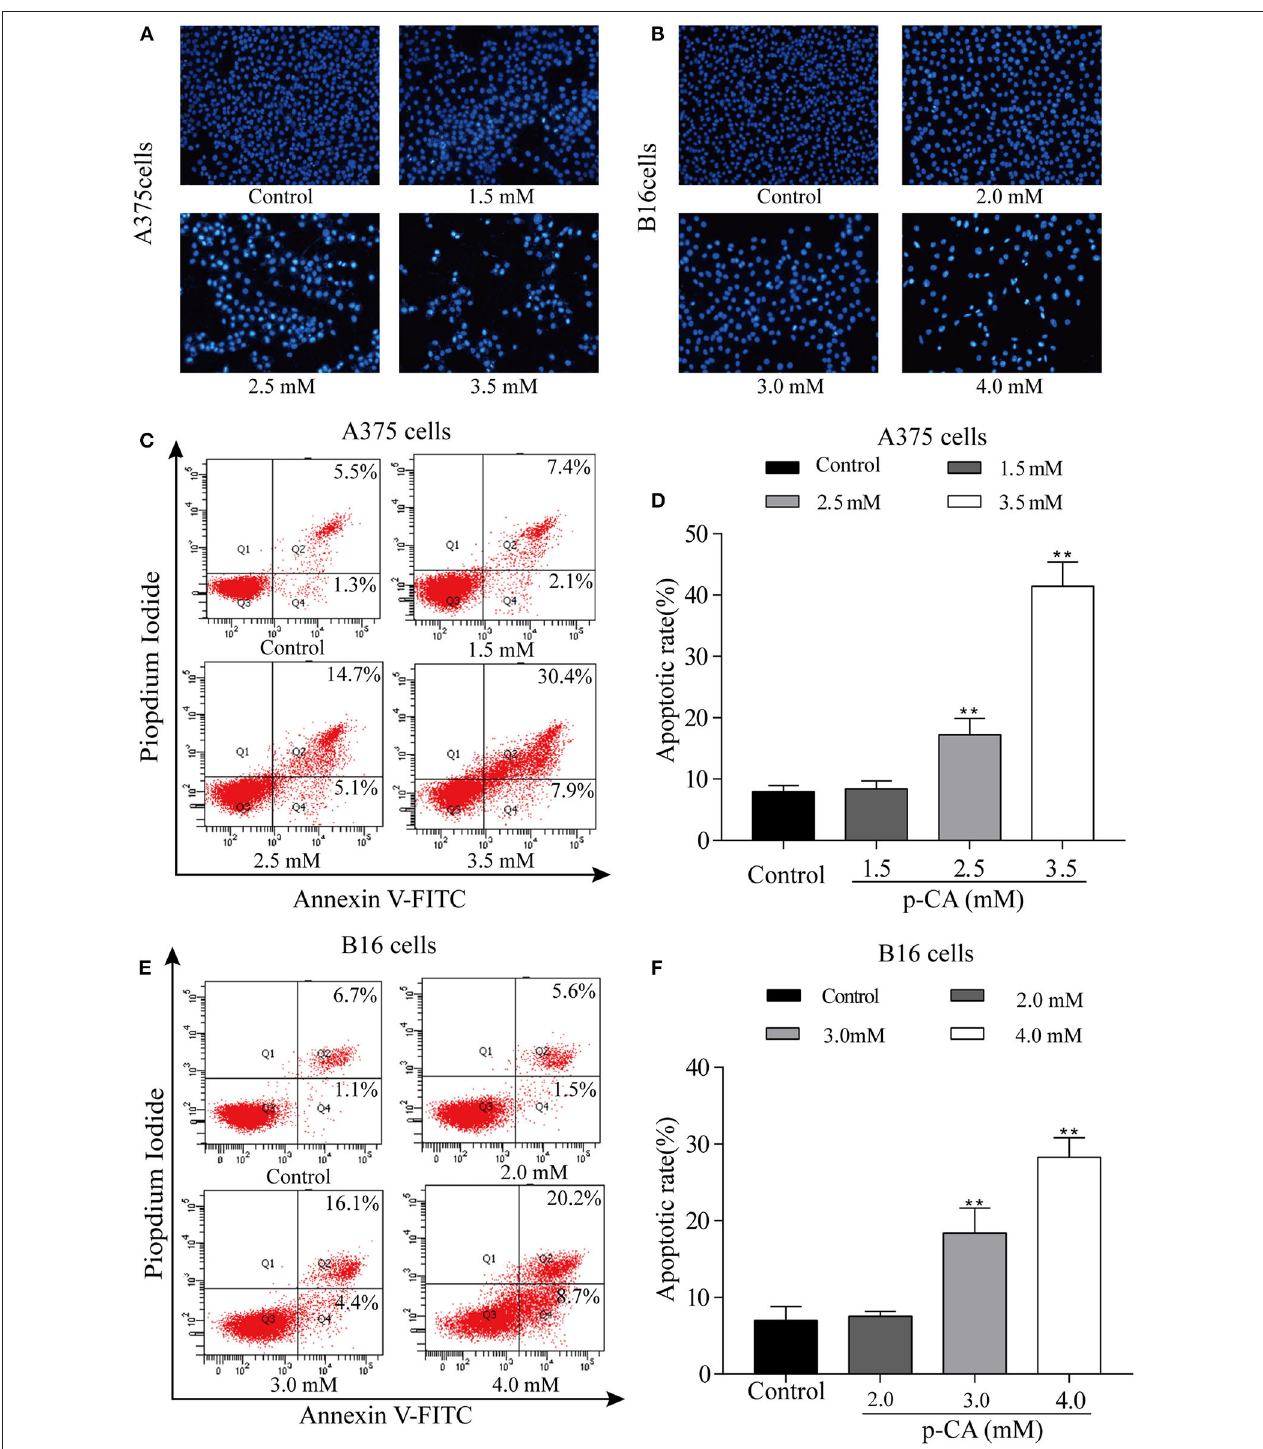
FIGURE 4 | p- CA induces A375 and B16 cell apoptosis. (A,B) After Hoechst 33,258 staining, the nucleus of A375 and B16 cells treated with p- CA showed morphological changes typical of apoptosis. (C) The apoptosis rate of A375 cells treated with p- CA was measured by Annexin V-FITC/PI double staining. (D) Statistical analysis of the apoptosis rate of A375 cells treated with p- CA. (E) The apoptosis rate of B16 cells treated with p- CA was measured by Annexin V-FITC/PI double staining. (F) Statistical analysis of the apoptosis rate of B16 cells treated with p- CA. All data are expressed as the mean ± SD of three independent experiments. ** P < 0.01 compared with the